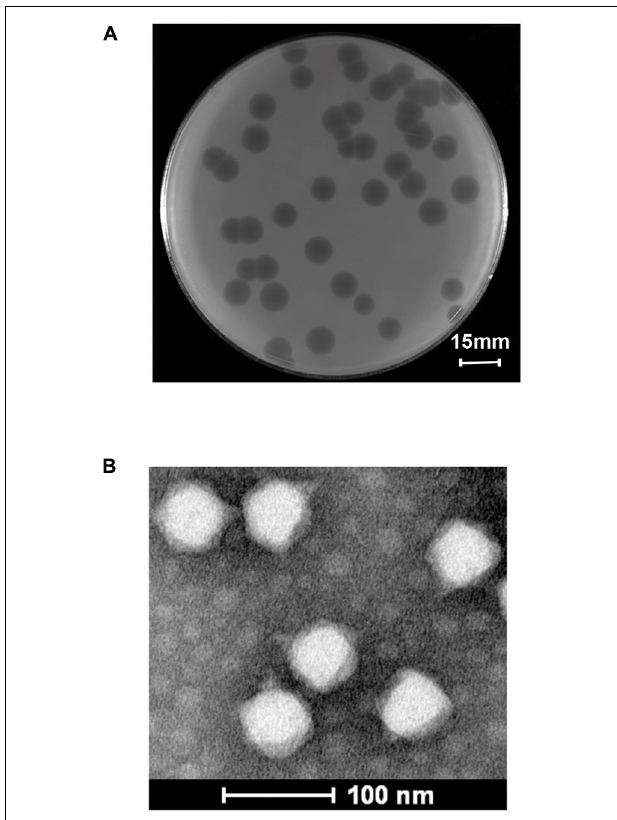
FIGURE 1 | Isolation and morphological analysis of phage vB_ShiP-A7. (A) Plaques of phage vB_ShiP-A7 on the top agar plate. The bar indicates 15 mm. (B) The morphology of phage vB_ShiP-A7 under transmission electron microscopy. The bar indicates 100